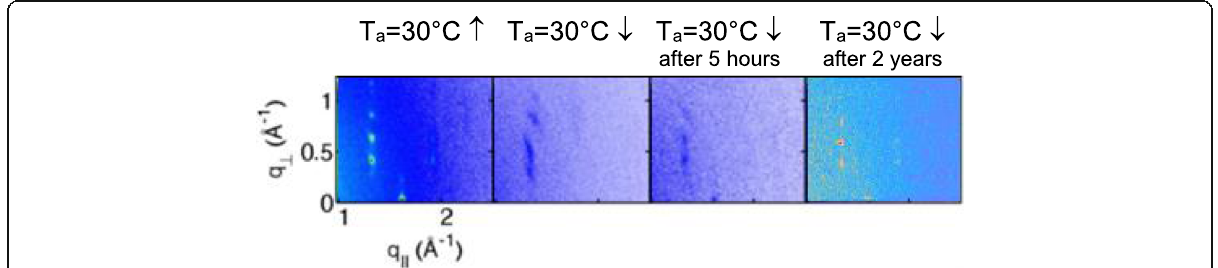
Fig. 5 Zoomed 2D-GIXD patterns of the pristine crystalline film: the one measured directly after annealing experiment, as well as the ones kept for 5 h and 2 years at room temperature (from left to right)